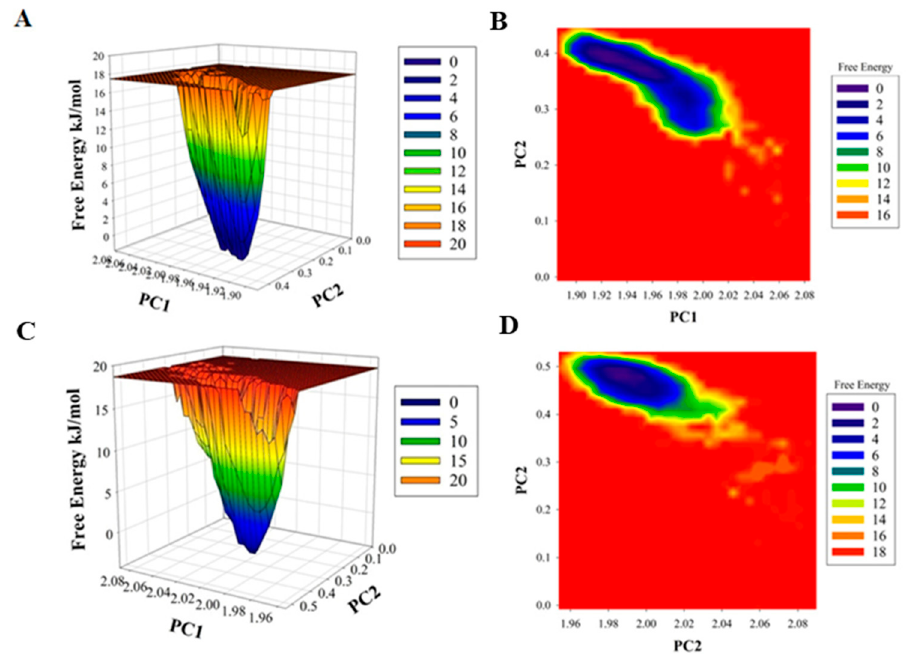
Figure 4. Plots of ( A ) free energy landscape and ( B ) Contour map for the of CDK6. A graphical representation of the ( C ) free energy landscape and ( D ) Contour map for the of CDK6-EA.